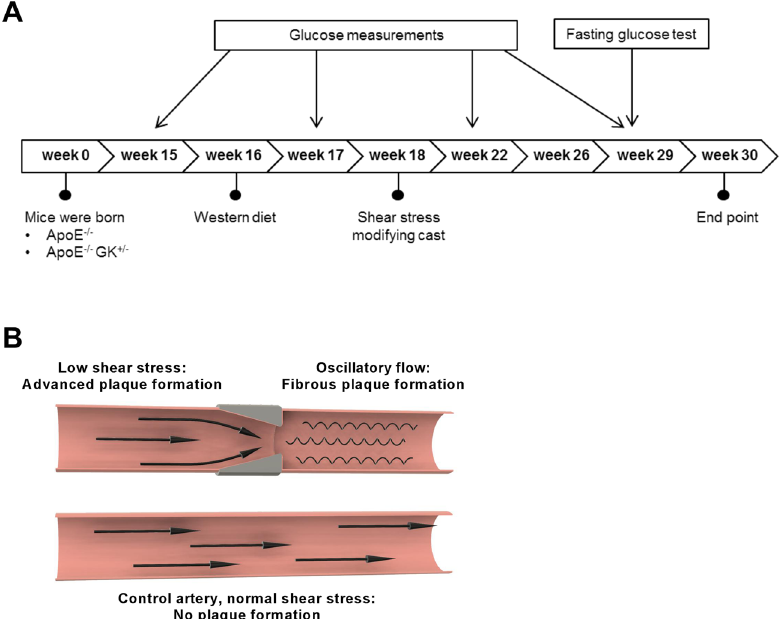
Figure 1. Schematic overview of the experimental mouse model. Timeline and setup over the experiment ( A ) and the shear stress-modifying cast that induces atherosclerotic plaques in the carotid artery ( B ).